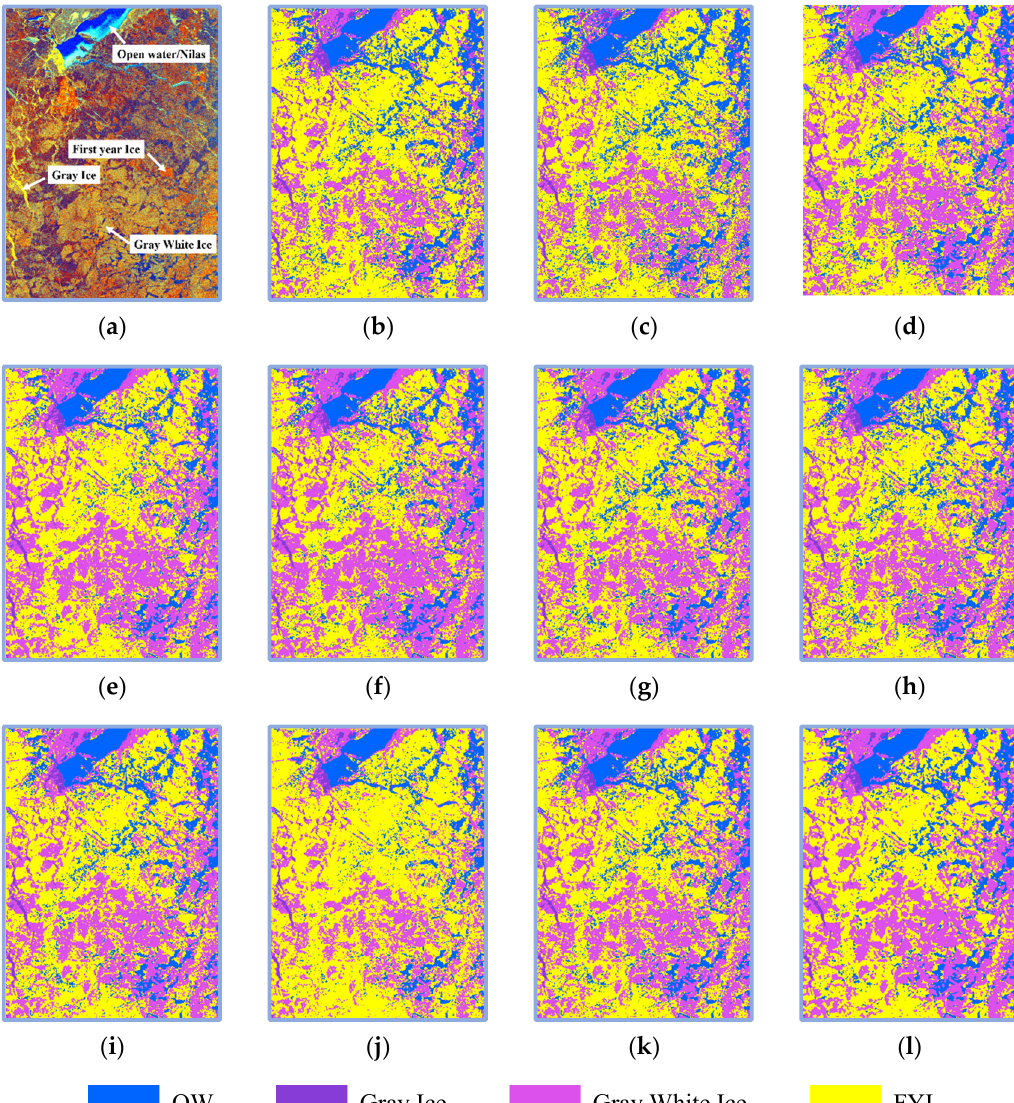
Figure 9. Visual comparison of sea ice classifications by the base classifiers and the ensemble learning method with multiple voting strategies on Image I. ( a ) False color image. ( b – g ) Results of the base classifiers of NB, DT, KNN, LR, ANN, and SVM. ( h – l ) Results of the ensemble classifier with voting strategies of MV, OA, PA, GA, and TRWV. MV: majority voting, OA: voting strategy with overall accuracy as weights, PA: producer accuracy as voting weights, GA: voting weights are optimized by a genetic algorithm, TRWV: the proposed two-round weight voting strategy-based ensemble learning method (TRWV).